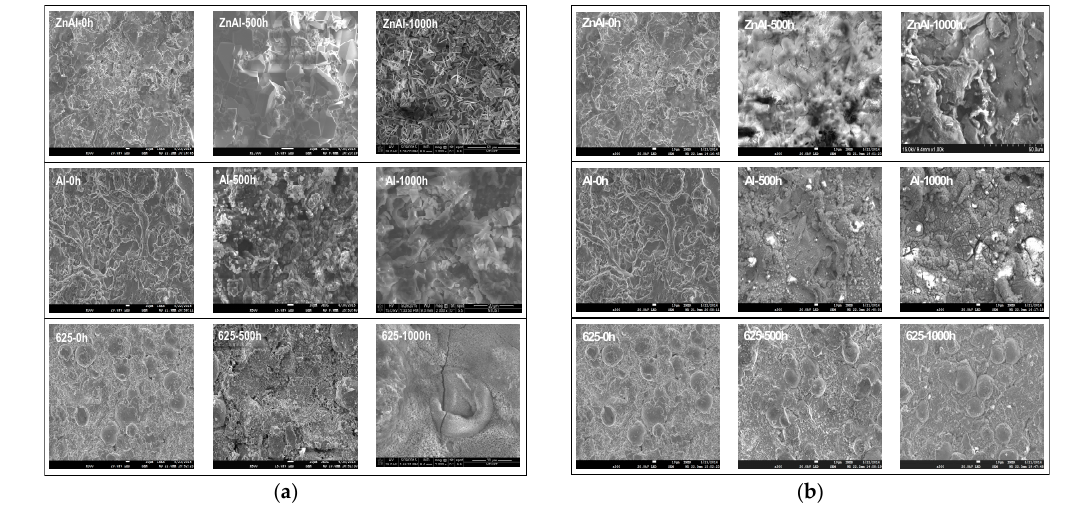
Figure 3. Surface morphology of the thermal spray coatings after corrosion test: ( a ) the NaCl deposition in a controlled environmental corrosion test; and ( b ) the immersion corrosion test in 3.5 wt % NaCl solution (the scale bars indicate 10- μ m).